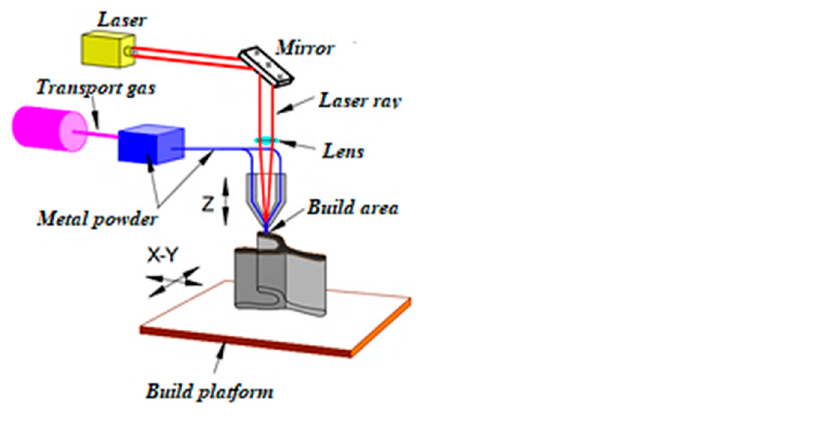
Figure 2. Schematic diagram of obtaining samples using direct laser deposition .